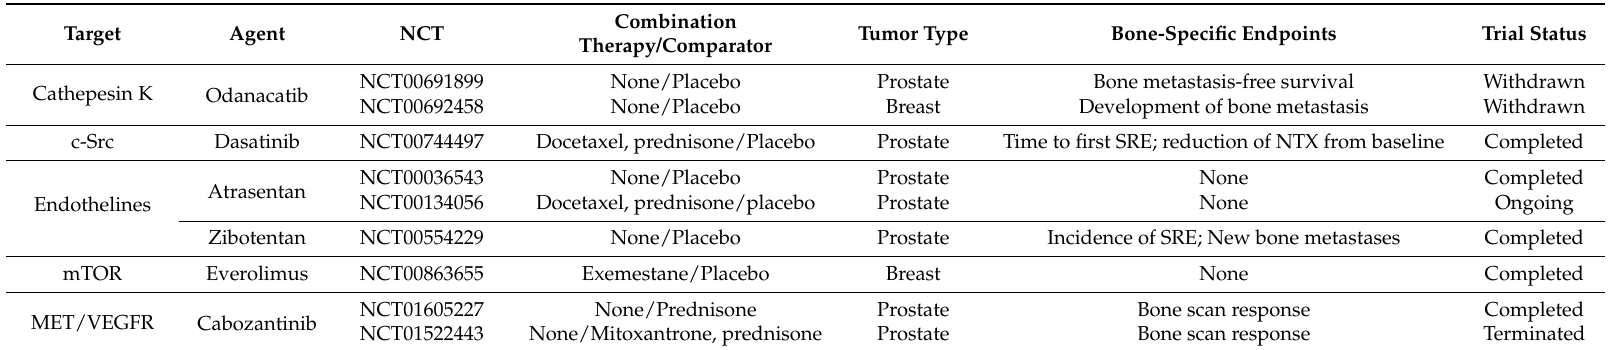
Table 3. Phase III trials testing new bone targeted agents (ongoing or closed/completed; excluding bisphosphonates, denosumab and radium-223) for the treatment of bone metastasis. For an in-depth analysis of clinical trials testing bone-targeted agents, see reference